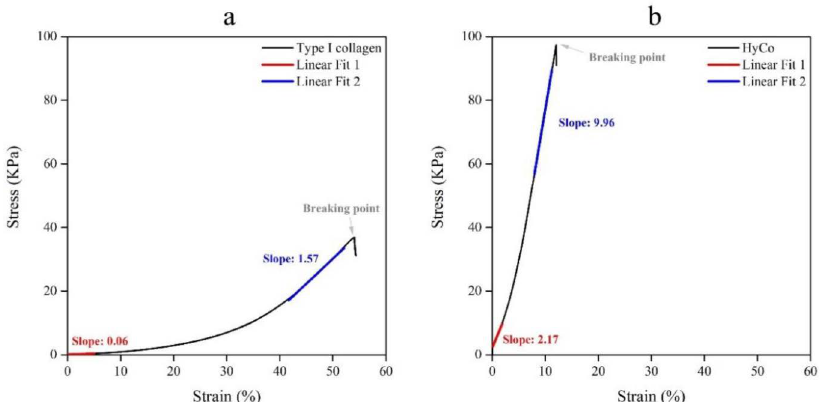
Figure 4. Stress–strain curves resulting from tensile tests of commercial collagen scaffold and HyCo and related Young’s Moduli. Type I collagen scaffold ( a ) and HyCo ( b ); HyCo scaffold displayed a significant statistical increase in both Young’s moduli with respect to the commercial collagen one. Slopes of straight lines were calculated on the linear portion of curves using least-squares fit on tensile test data by means OriginPro 2016 software (OriginLab, Northampton, MA, USA).